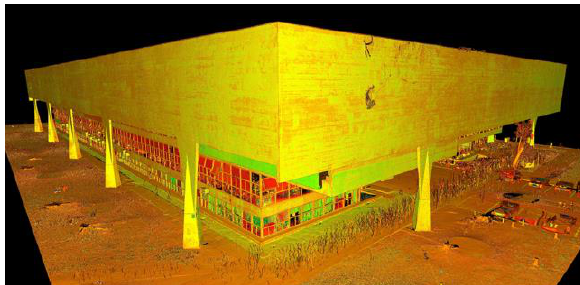
Figure 1. External view of the FAU USP building